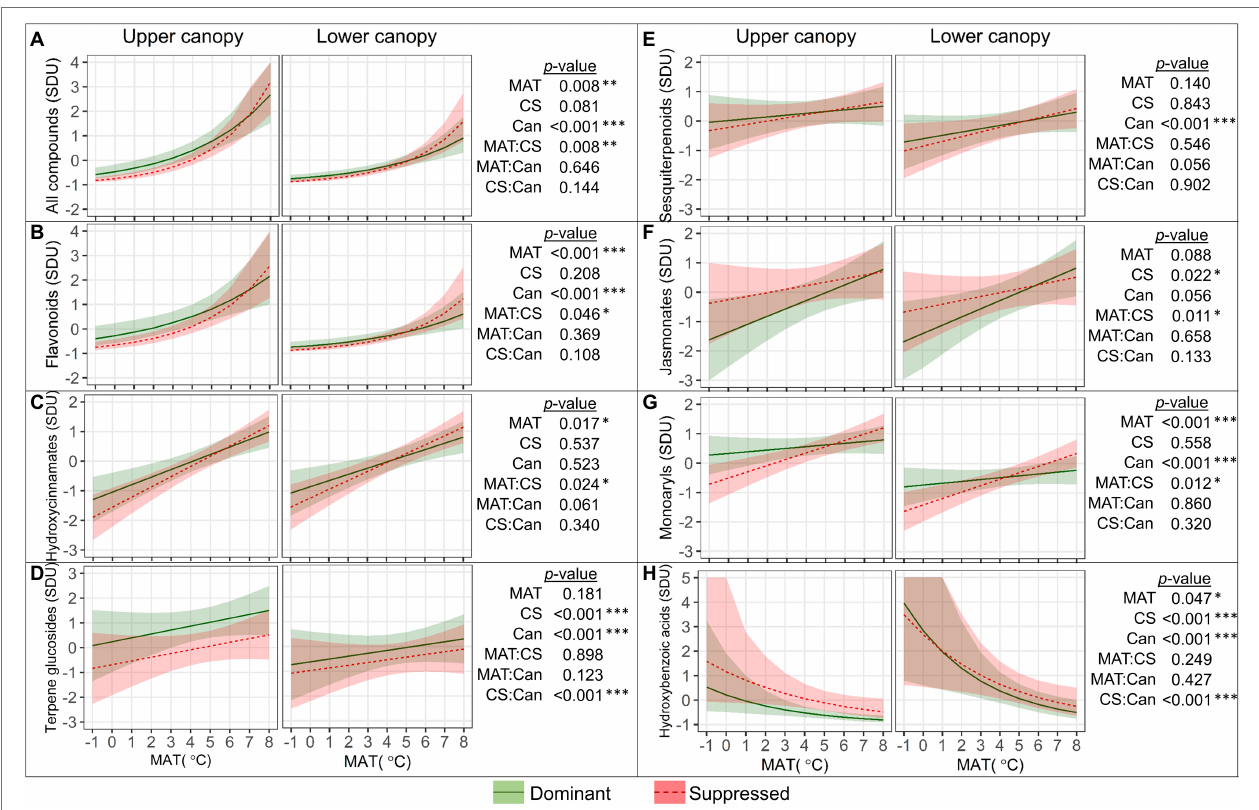
FIGURE 4 | Relationships between the quantity (SDU, standard deviation units) of all foliar secondary metabolite compounds (A) and groups of compounds (B–H) with mean annual temperature (MAT) in the upper and lower canopy of competitively dominant and suppressed silver birches (predicted mean trend with 95% confidence bands based on LMM). Curvilinear trendlines indicate that data were log -transformed prior to LMM analysis and the model predictions were back- transformed for data visualization. The significance of the factors (MAT; CS, competitive status; Can, canopy position) is shown next to the graphs: * p < 0.05, ** p < 0.01, *** p <